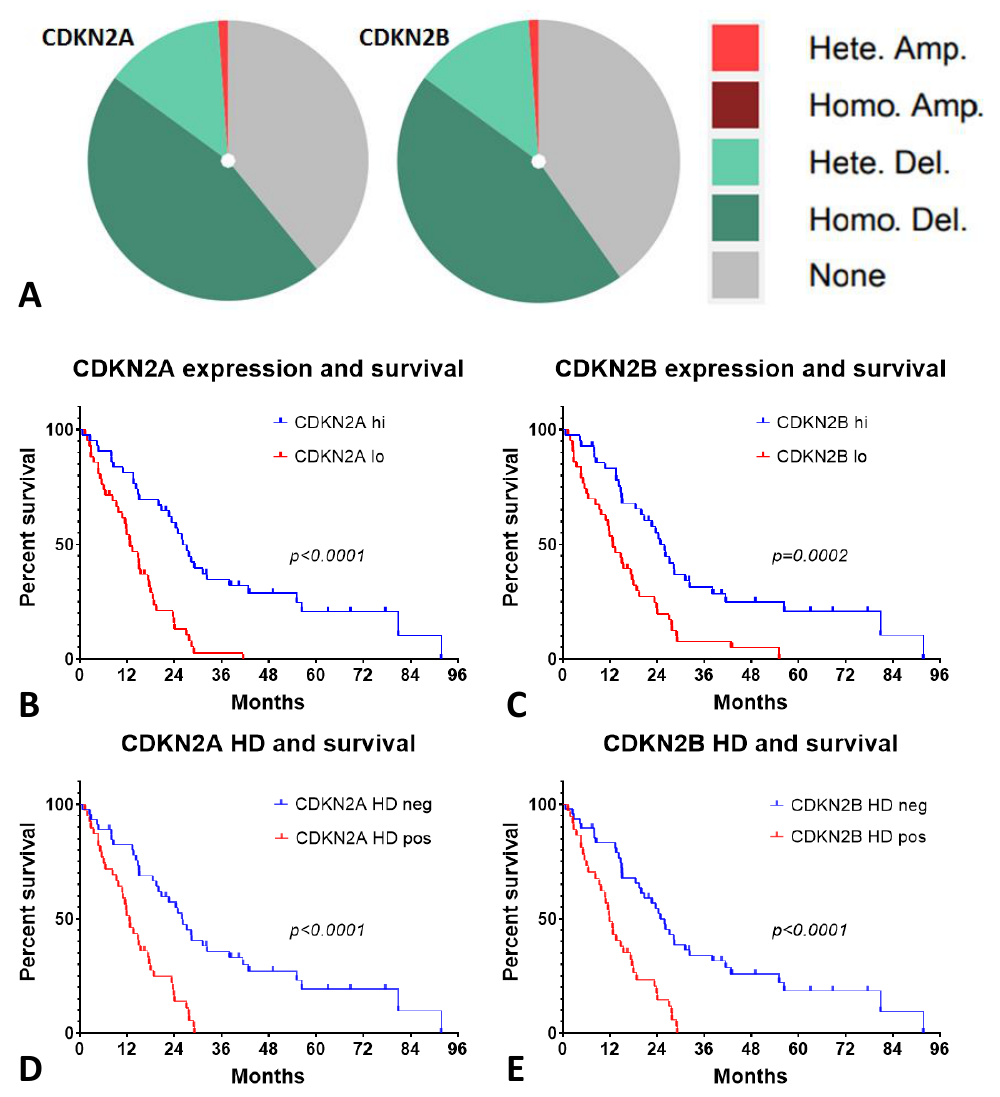
Figure 6. CDKN2A/B genomic alterations in TCGA database CDKN2A expression and homozygous deletion had an inverse effect on survival in MESO. ( A ) Homozygous deletion (HD) and heterozy- gous deletion of CDKN2A and CDKN2B genes are one the most frequent alterations in MESO; ( B , C ) lower expression of CDKN2A and CDKN2B genes are associated with worse survival in MESO; ( D , E ) homozygous deletion (HD) positivity of CDKN2A or CDKN2B are associated with worse survival in